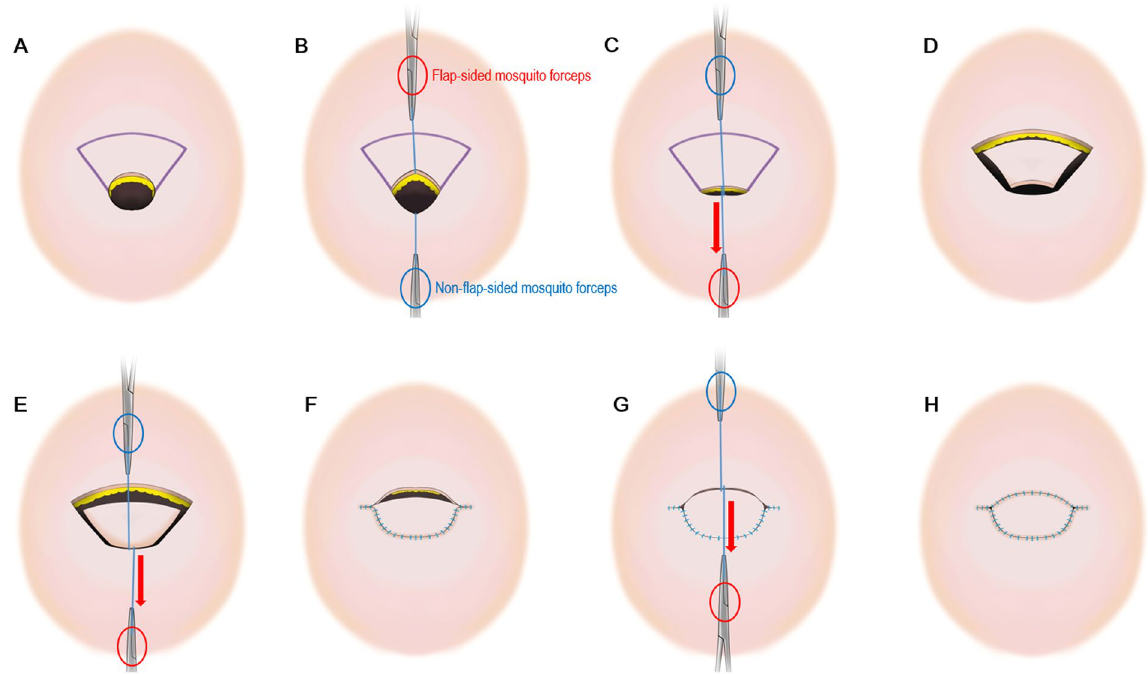
Figure 5. Schematic diagram of the keystone-design perforator island flap (KDPIF) and tension measurement procedures performed during excision of the epidermoid cyst on the back. Red-coloured oval represents the flap-sided mosquito forceps, and blue-coloured oval represents the non-flap-sided mosquito forceps. ( A ) Design of the KDPIF after complete excision of the complicated epidermoid cyst (EC). ( B , C ) Measurement of the ‘pre-flap tension at the defect’. ( D ) Complete elevation of the KDPIF, which is fully released and detached from the surrounding tissues. ( E ) Measurement of the ‘post-flap tension at the defect site’. ( F ) Defect-side flap closure achieved. ( G ) Measurement of the ‘post-flap tension at the donor site’. ( F ) Donor-side flap closure